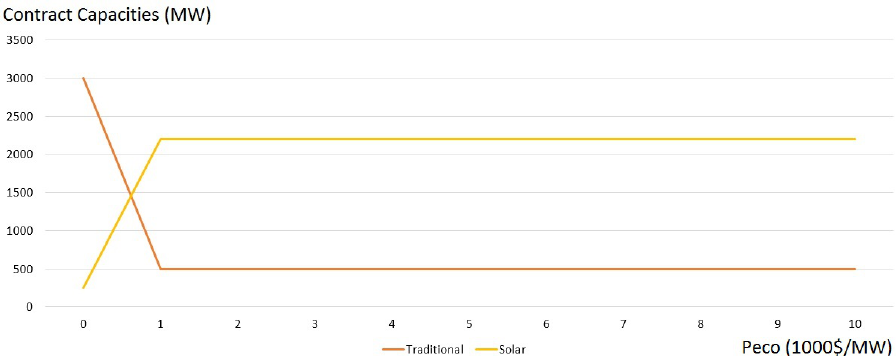
Figure 8. Variation of the optimal traditional and solar energy contract capacity with respect to P eco and for all σ values (own results).